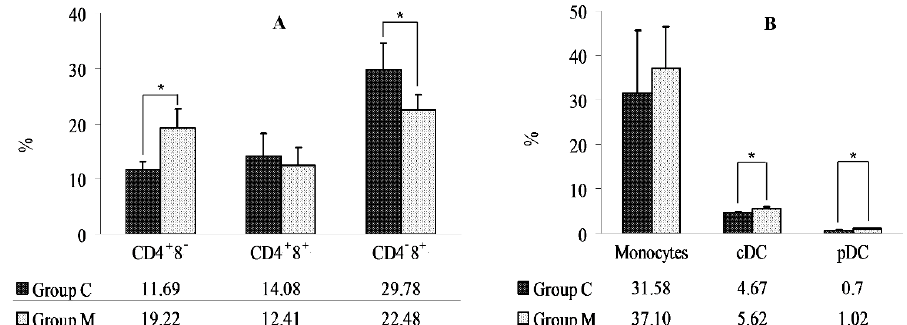
Figure 2. ( A ) Changes in the percentage of CD4 + 8 − , CD4 + 8 + , and CD4 − 8 + cells in groups M and C; ( B ) Changes in the percentage of monocytes, cDCs, and pDCs in groups M and C. The results were expressed as x and SD. *: statistically significant differences at p ≤ 0.05.